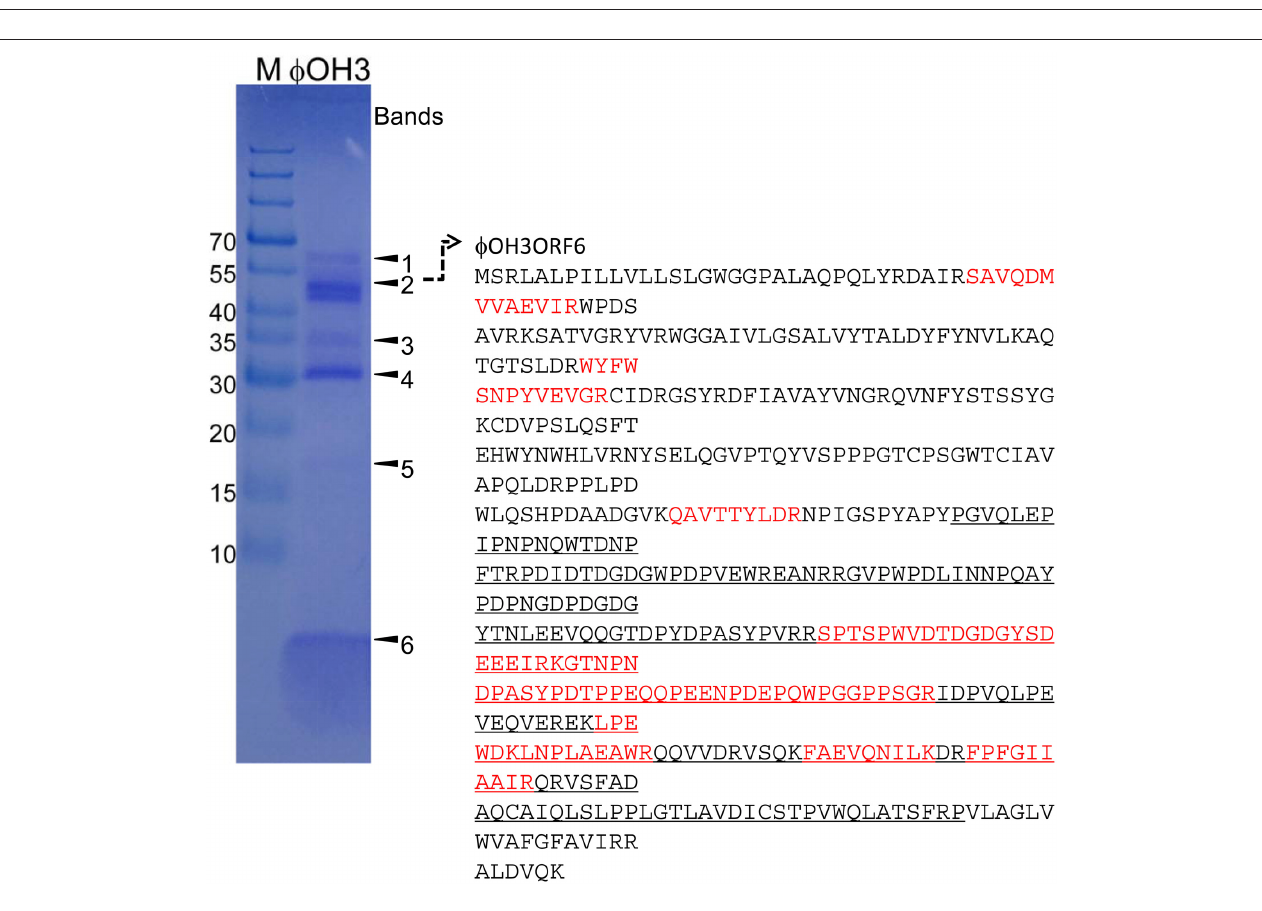
FIGURE 7 | SDS-PAGE of proteins from purified ϕ OH3 virions staining with Coomassie brilliant blue R250. The numbers indicate the bands excised for mass spectrometric analysis (Supplemental Tables 1, 2). The left lane contains protein molecular mass markers (kDa). Red colored and underlined characters indicate matched peptides and domain of DNA translocase FtsK